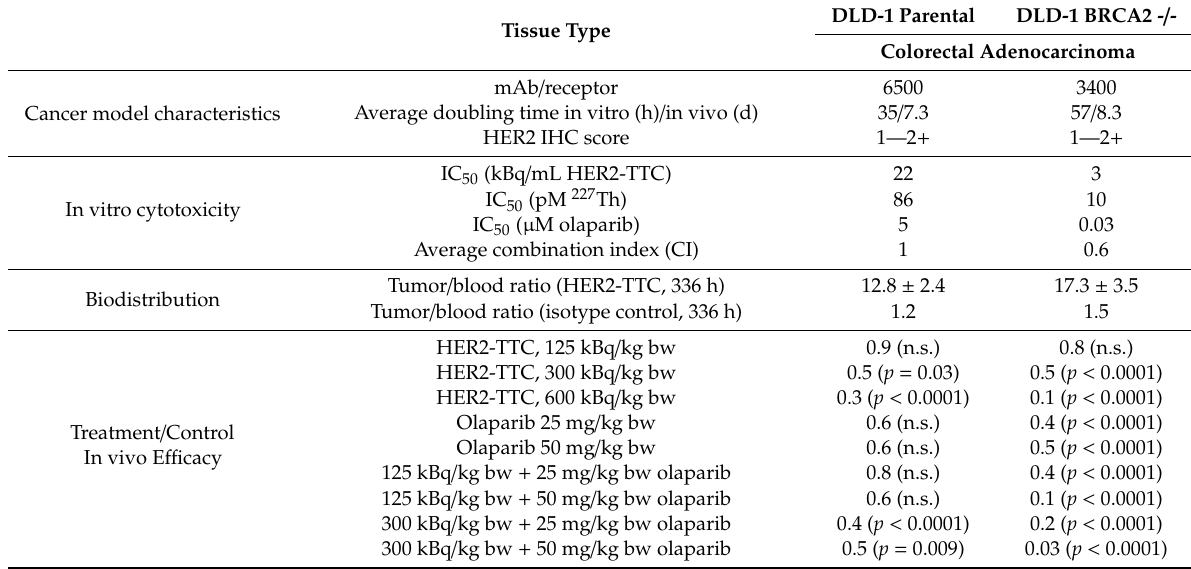
Table 1. Summary of in vitro cellular experiments, biodistribution, and in vivo e ffi cacy studies, using the isogenic cell line pair DLD-1 parental and DLD-1 BRCA2 - / -. In vitro experiments comprised determination of cell surface HER2 antigens by flow cytometry and cytotoxicity experiments. In vivo, the biodistribution of HER2-TTC was compared to radiolabeled isotype control. Respective tumors to blood ratios 336 h after start of treatment are presented. Treatment over control ratio, including statistical significance compared to vehicle, were determined from the respective e ffi cacy